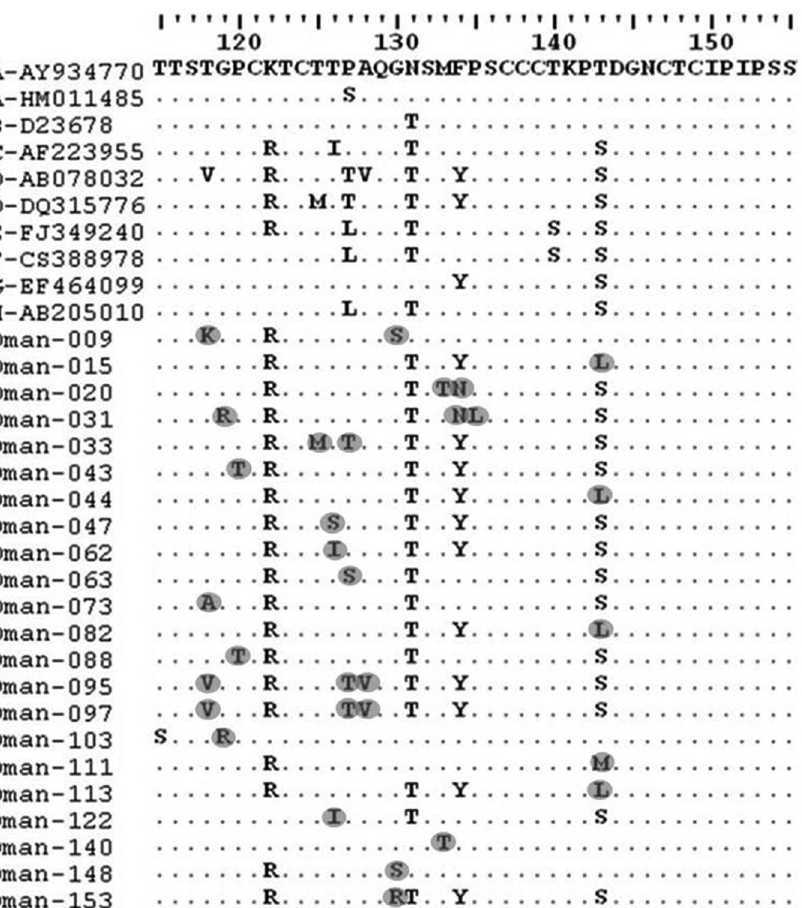
Figure 2. Analysis of escape mutants of Omani HBV isolates. The amino acid sequences in the ‘‘a’’ determinant region of the Omani escape mutant isolates were aligned with the corresponding region of the reference sequences (HBV-genotypes A to H; GenBank accession numbers are denoted) by ClustalW with Neighbor Joining method and 1000 bootstrap replicates. Amino acid substitutions were highlighted.